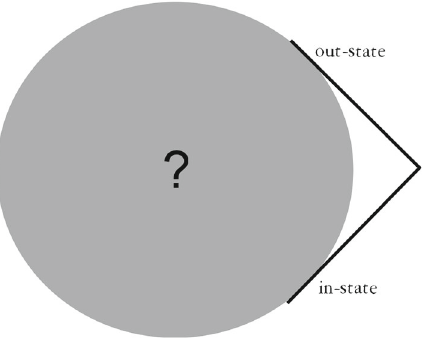
Fig. 1 We want to know the scattering amplitude from the in-state to the out-state